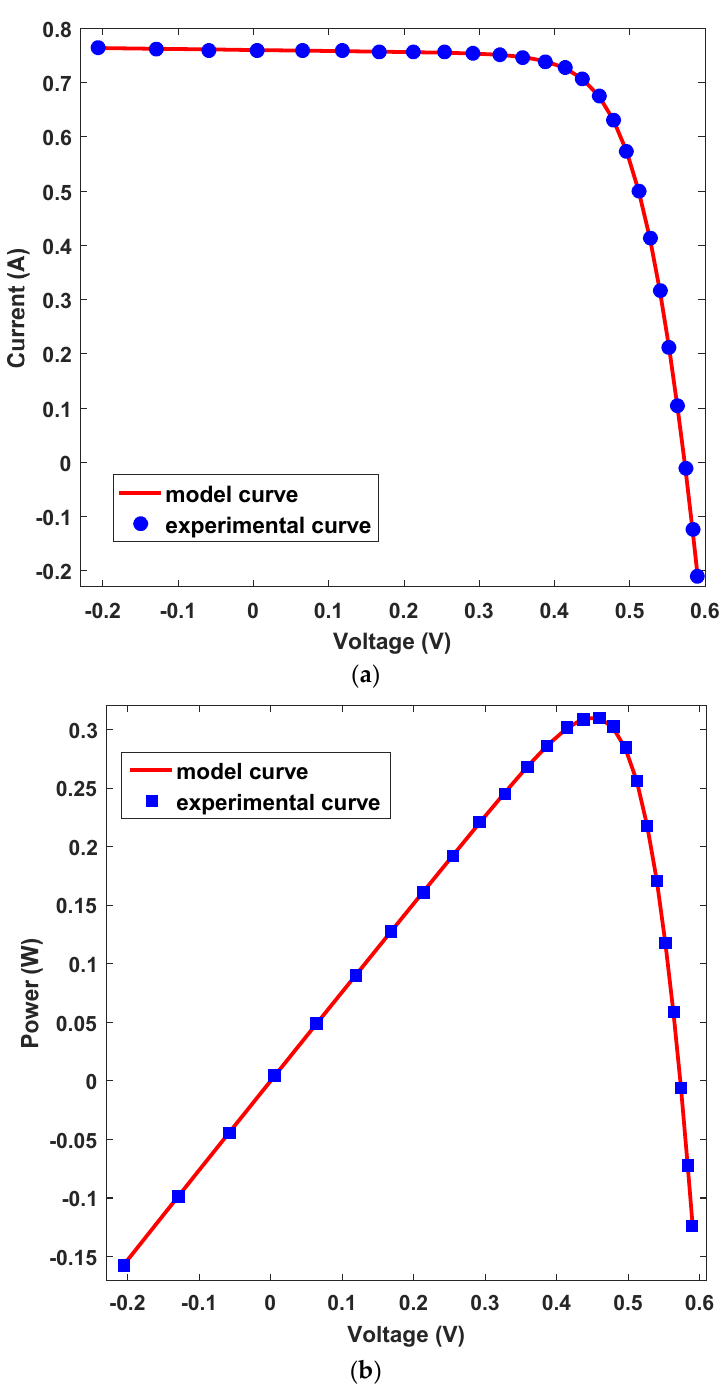
Figure 15. Comparisons between measured data and data achieved using the MECPO method for DDM ( a ) I–V characteristics and ( b ) P–V characteristics.